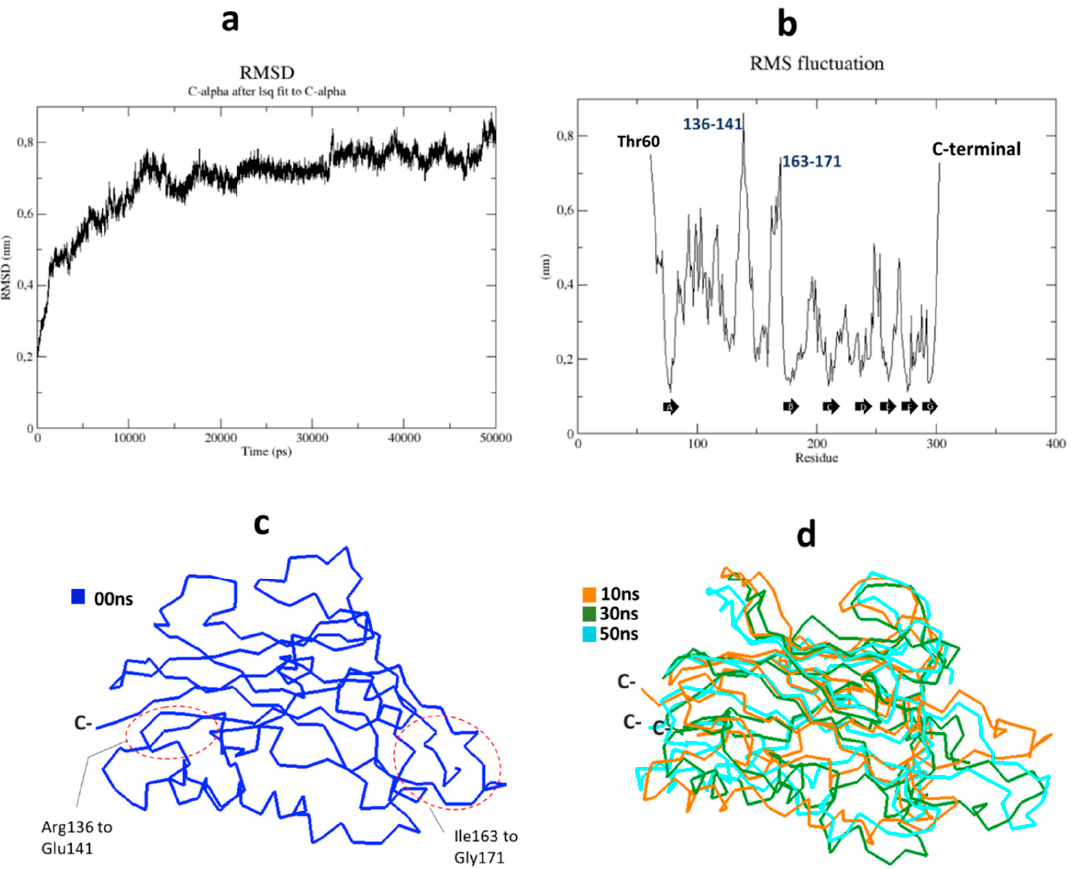
Figure 2. Molecular dynamics simulations of ED β 1 . ( a ) RMSD (Root Mean Square Deviation) plot of C α computed during 50ns for ED β 1 . ( b ) RMSF (Root Mean Square Fluctuation) plot of ED β 1 . Besides C and N terminal ends, segments with the highest fluctuation correspond to residues R136–E141 and I163–G171, respectively. Black arrows indicate the β -sheet secondary structure. ( c ) Ribbon representation of ED β 1 before the simulation (native structure, blue). The structure suffers important RMS fluctuation in two loops (red ovals) corresponding to those highlighted in Figure 2B. ( d ) Conformers of ED β 1 at the beginning (10 ns conformer, orange), middle (30 ns conformer, green) and end of the simulation (50 ns conformer, cyan).